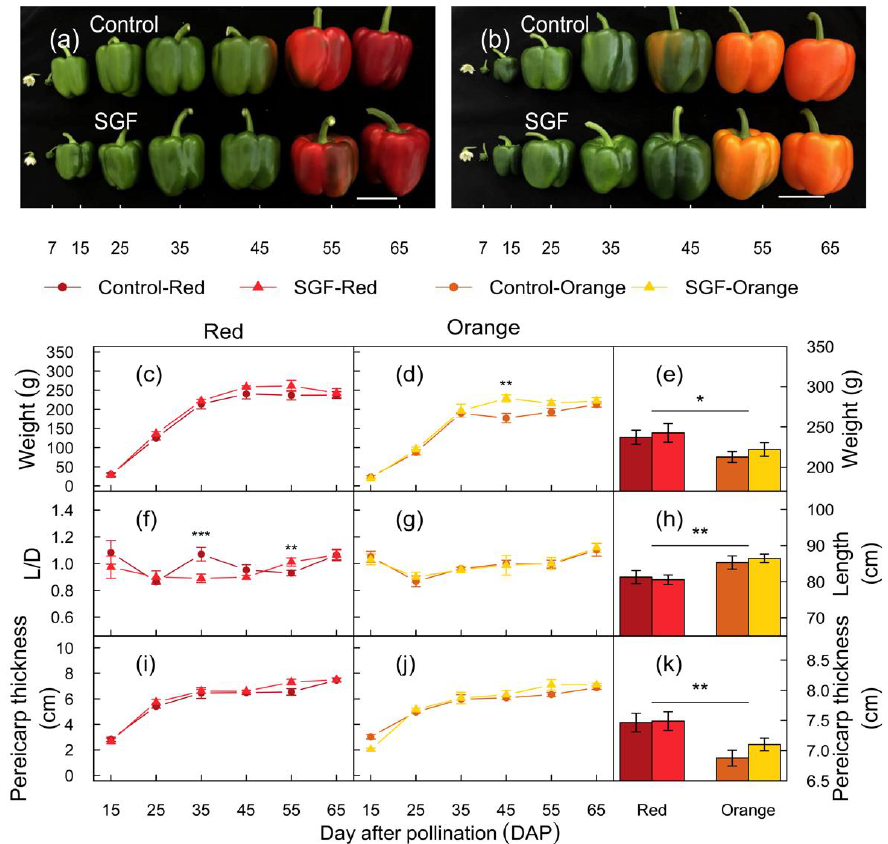
Figure 1. Morphology and development of fruits from plants grown under the SGF. ( a , b ) Photos showing morphological features of representative Red ( a ) and Orange ( b ) cultivar fruits harvested from plants grown under SGF or diffuse control glass. Images depict different stages of fruit devel- opment (7 to 65 DAP). Scale bars (5 cm) are displayed. ( c – k ) Red and Orange fruit developmental parameters measured during stages of development (15 to 65 DAP). Line graphs display fruit weight ( c – e ), length to diameter ratio (L/D; f – g ), length ( h ), and pericarp thickness ( i – k ). Mean values and standard error bars ( n = 12 fruits from two experimental bays) are displayed. Bar plots depict the average of fruit weight ( e ), length ( h ), and thickness of pericarp ( k ) of Red and Orange fruits at the mature stage of development (65 DAP). Horizontal lines and stars denote statistical significance analyzed by one-way ANOVA (*: p ≤ 0.05, **: p ≤ 0.01, and ***: p ≤ 0.001). Abbreviations: Smart Glass Film (SGF); days after pollination